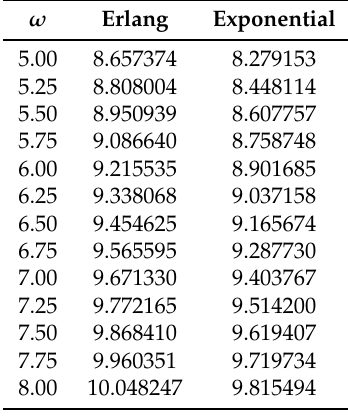
Table 4. The effect of the main server’s vacation rate on expected queue length for the values